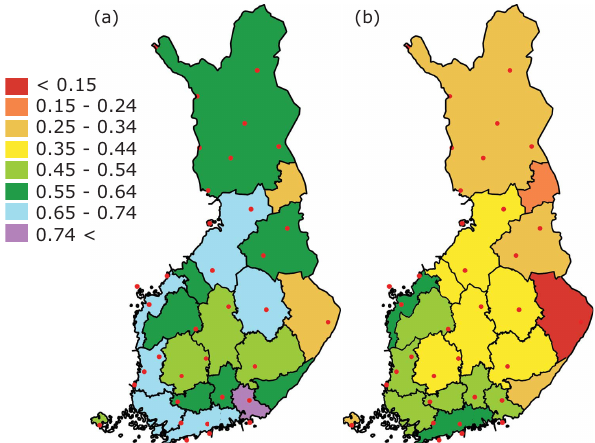
Fig. 3. The coefficient of determination ( R 2 ) of the linear multi- regression models for (a) FDD4 and (b) FDD5. The red dots mark the locations of the observation stations with FFI